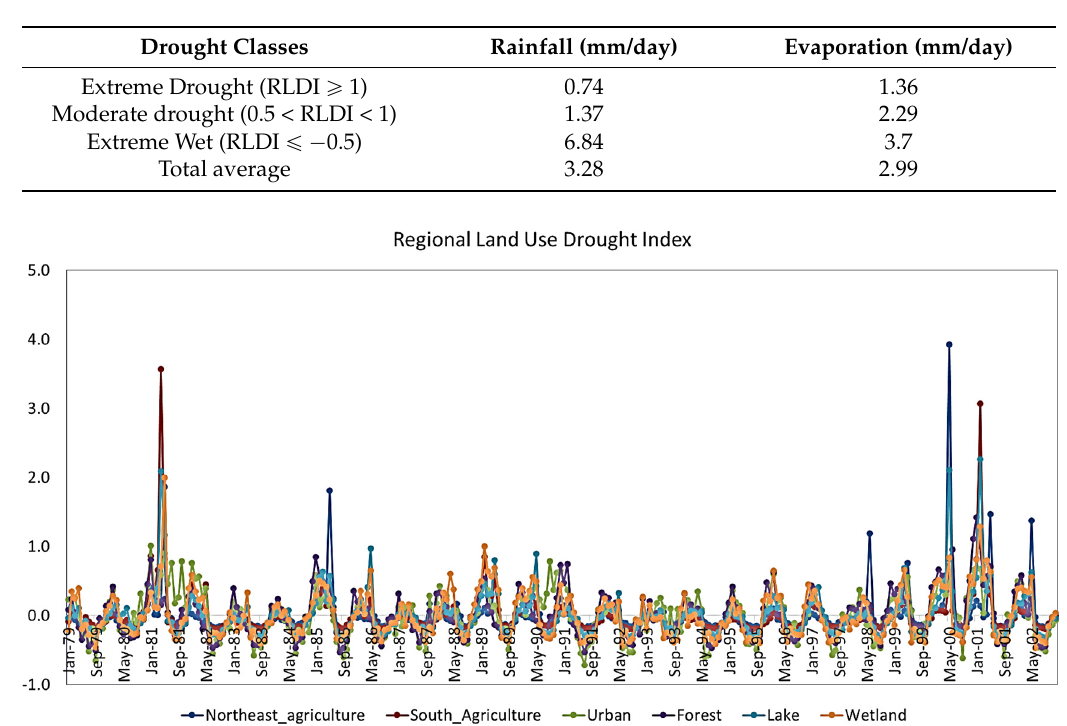
Table 3. The Classification of Regional Land Use Adapted Drought Index (RLDI).